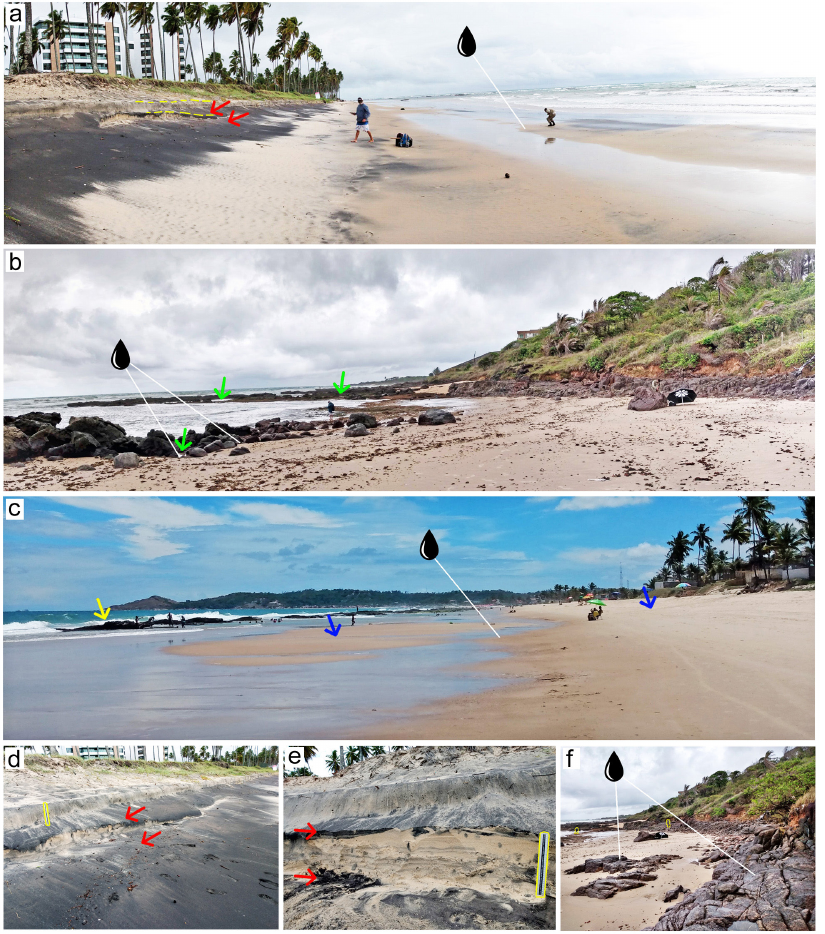
Figure 4. Characteristics of the studied beaches. a) Picture of the southern sector of Paiva Beach, looking toward the northeast. Dashed yellow lines show the scarp limit of the most recent erosive processes. b) Rocky shore of Itapuama Beach, looking toward the southeast. Green arrows indicate small pools. c) Picture of the Enseada Beach, looking toward the south-southeast. Blue arrows indicate the backshore and foreshore zones. The yellow arrow indicates beachrocks. d) and e) Red arrows show scarps formed by recent erosion and two beds containing seasonally deposited heavy minerals (yellow marker - 30 cm ruler). f) Rock surfaces in the upper part of the foreshore of Itapuama and rocks outcropping where the foreshore region is covered by sand. The black drop symbol indicates tar occurrences found during the study. Pictures were taken in March 2021 during low